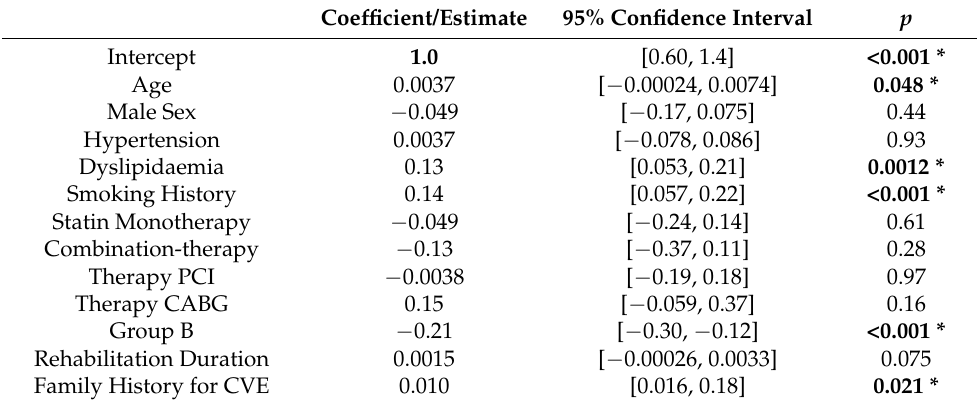
Table 3. Quantile Regression Weights for LDL-C at CR